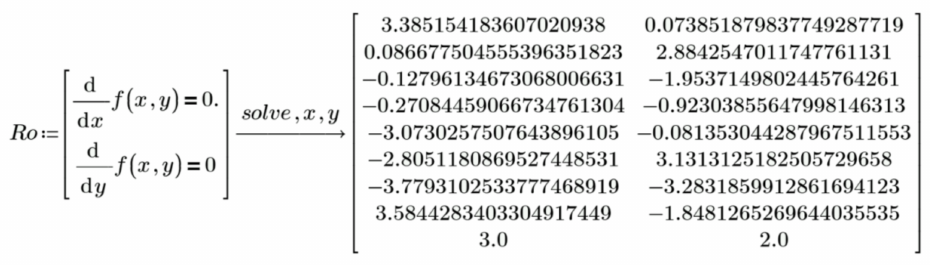
Figure 26. Solving a system of equations composed of the partial derivatives of the Himmelblau’s function.